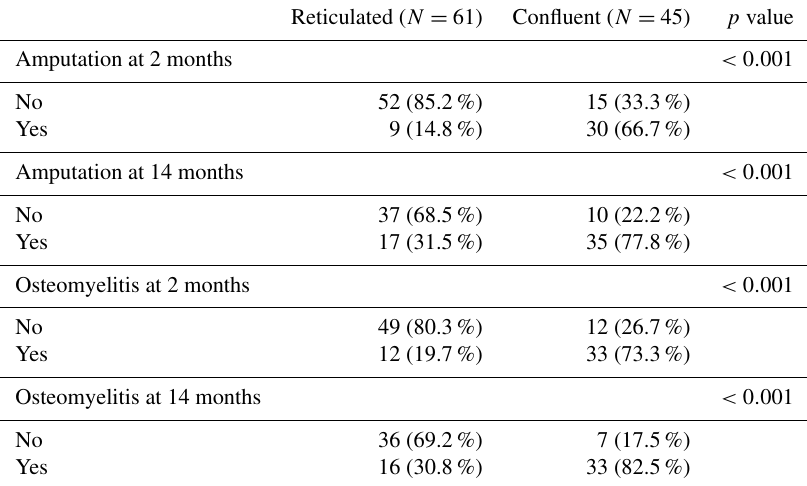
Table 3. Post hoc pairwise testing between the confluent and reticulated T1 bone marrow signal groups. Reticulated ( N = 61) Confluent ( N = 45) p